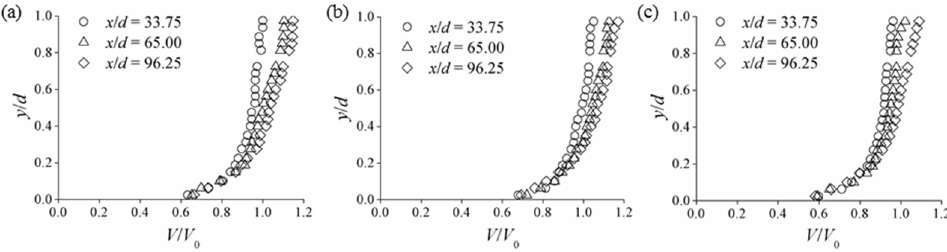
Figure 6. Velocity distributions in cross-sections along the flow direction: ( a ) Q = 0.18 m 3 /s; ( b ) Q = 0.19 m 3 /s; ( c ) Q = 0.21 m 3 /s.